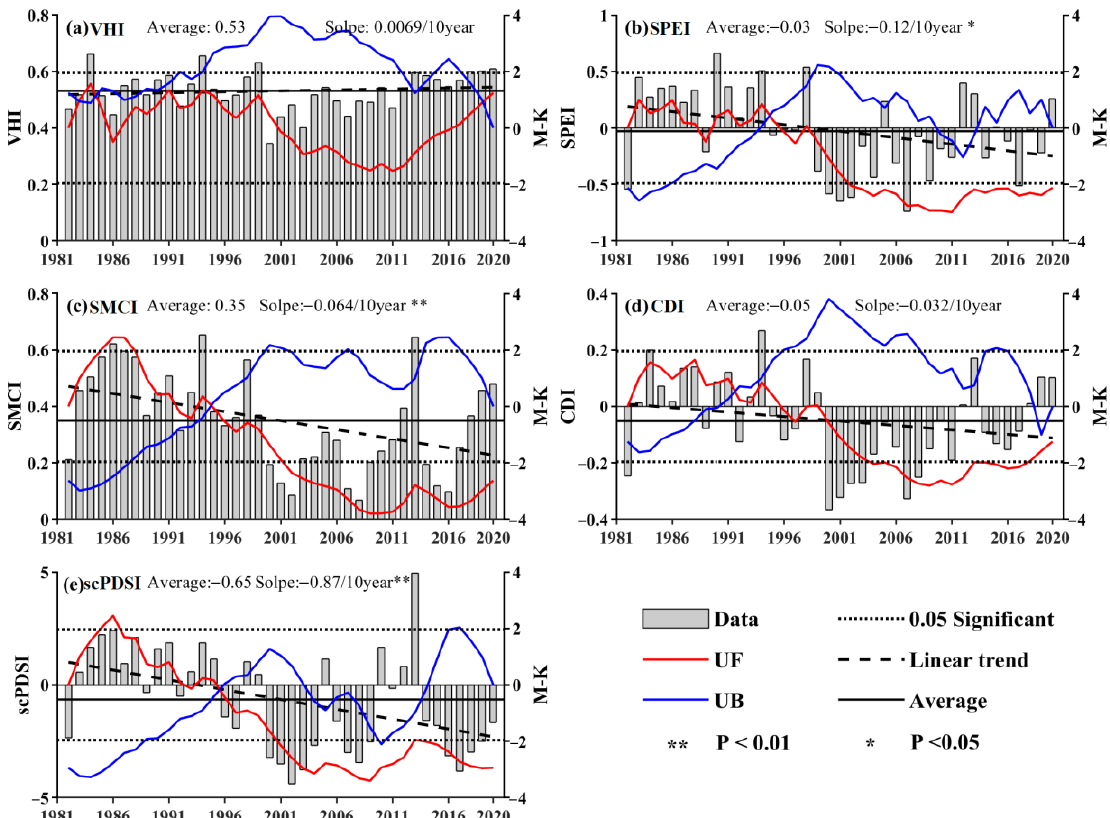
Figure 5. Temporal variation of different drought indices in the growing season of crops in NEC from 1982 to 2020 ( a – e